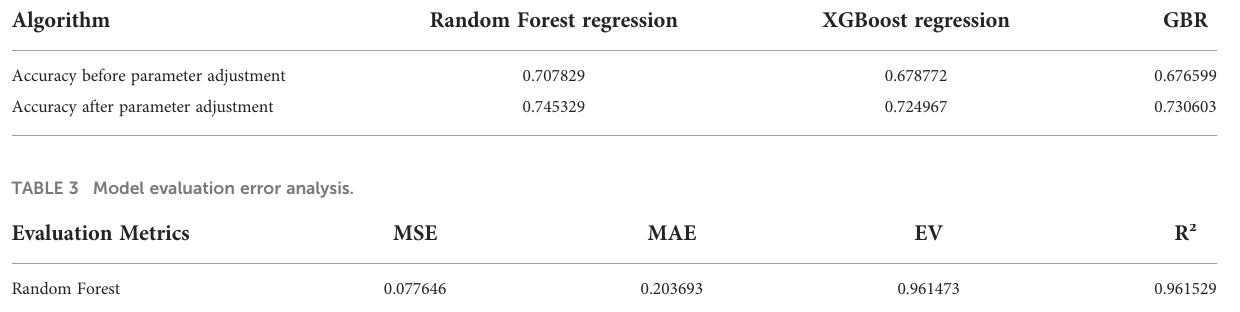
TABLE 2 Comparison of accuracy before and after parameter